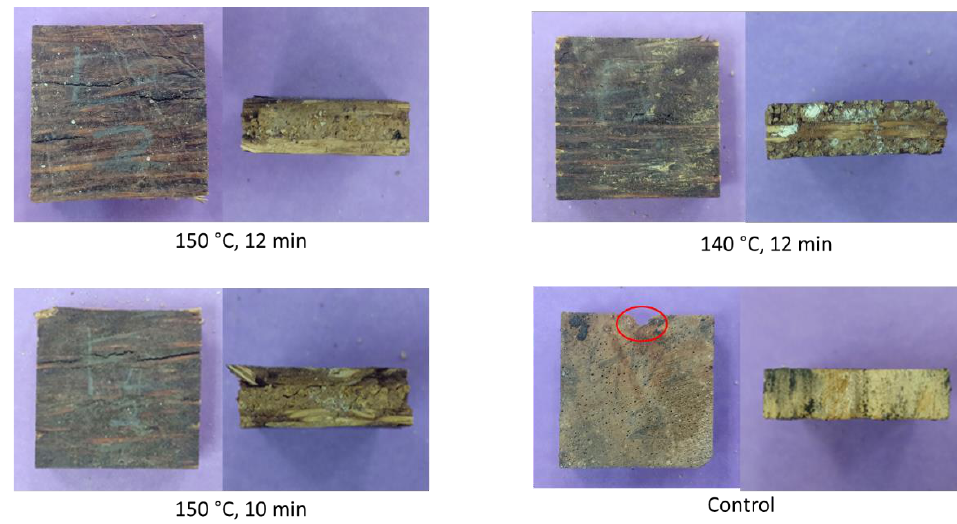
Figure 8. Visual appearance of the MGE plywood and control samples after a 4-week exposure to subterranean termites. Note: Red circle in control sample showed sign of attack by termites